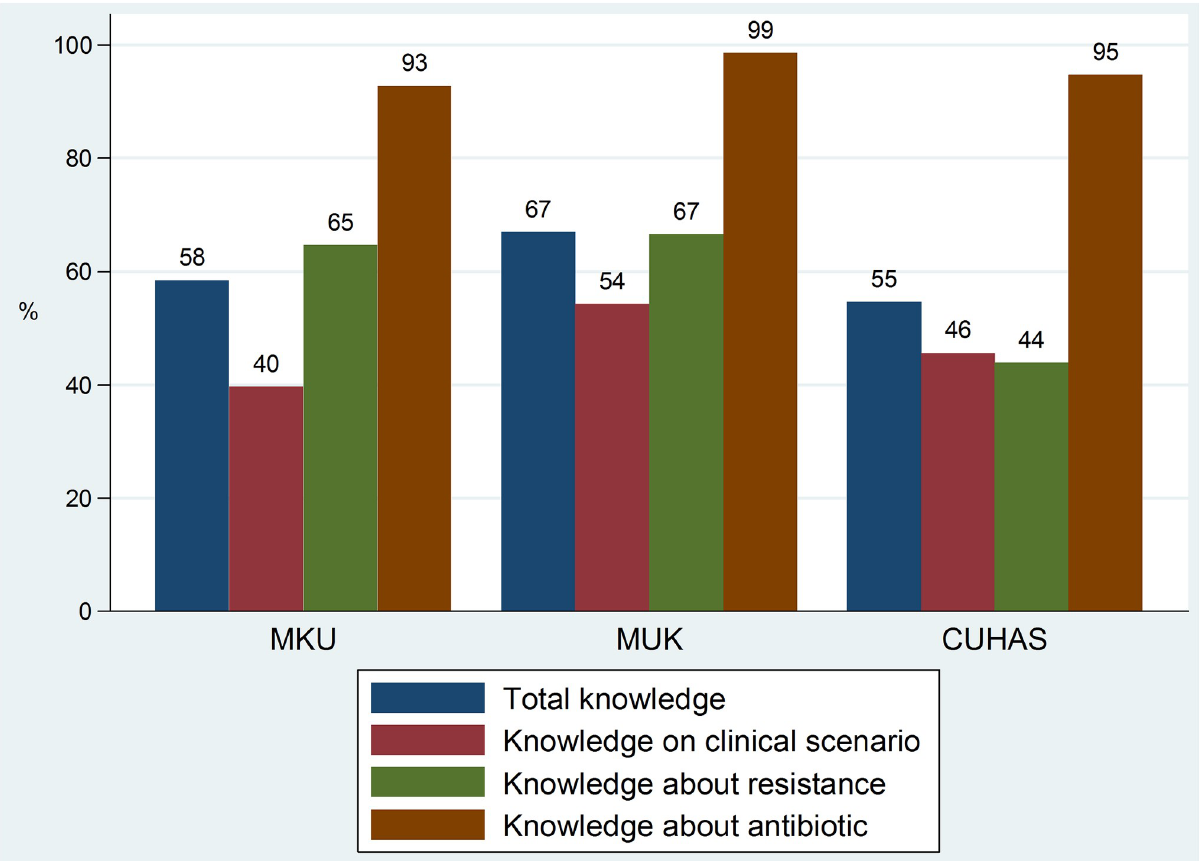
Fig 1. Mean scores of knowledge of final year students stratified by university.